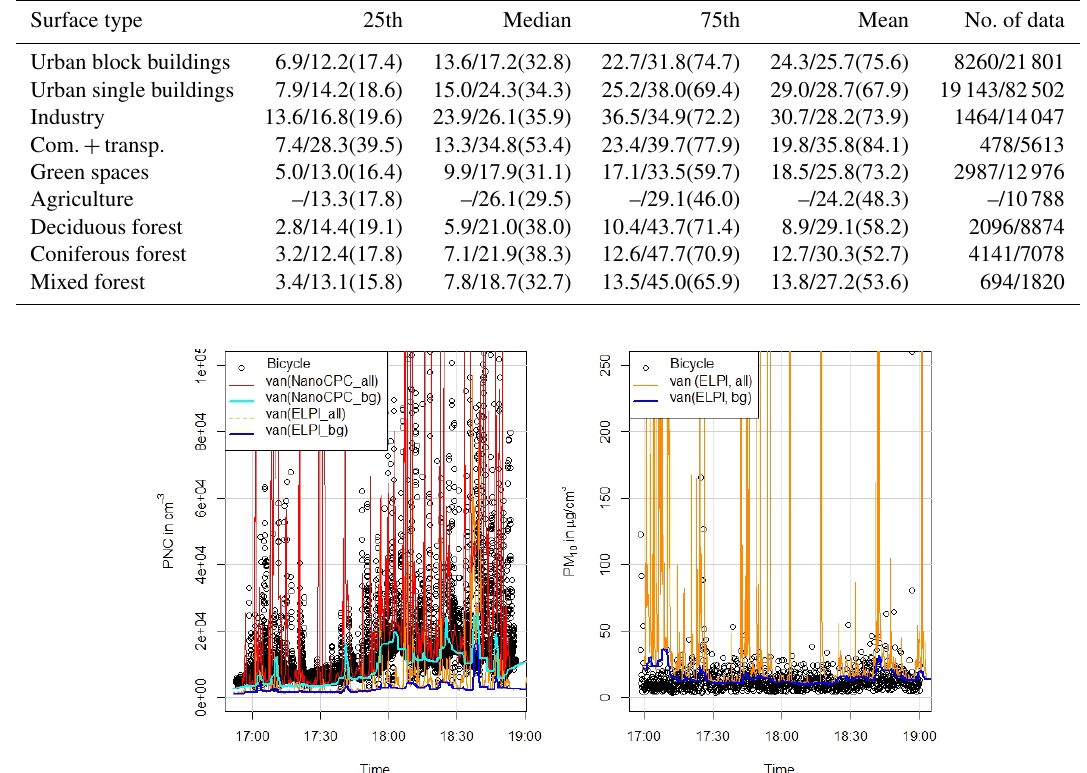
vehicles, the major traffic routes such as (iii) Frankfurter Allee (east), (iv) Mehringdamm (south), (v) Westkreuz and (vi) AVUS (west), as well as (vii) around the central